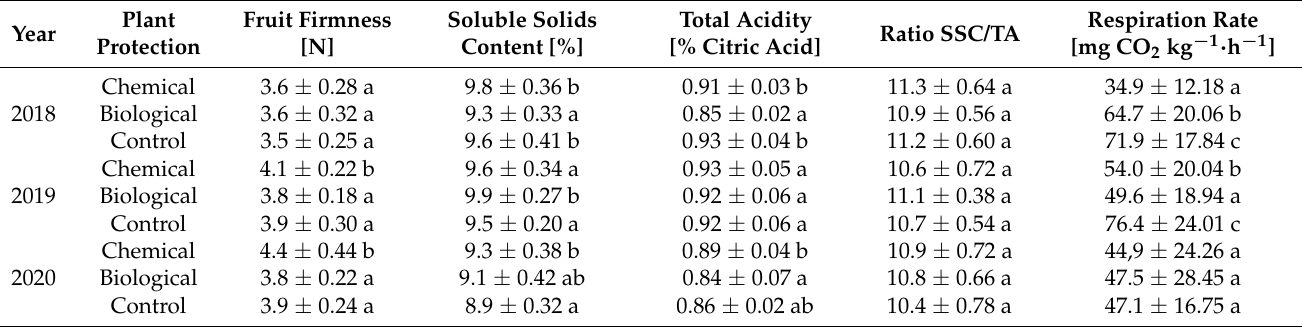
Table 5. Fruit quality of ‘Albion’ strawberry directly after harvest, average for harvest dates.